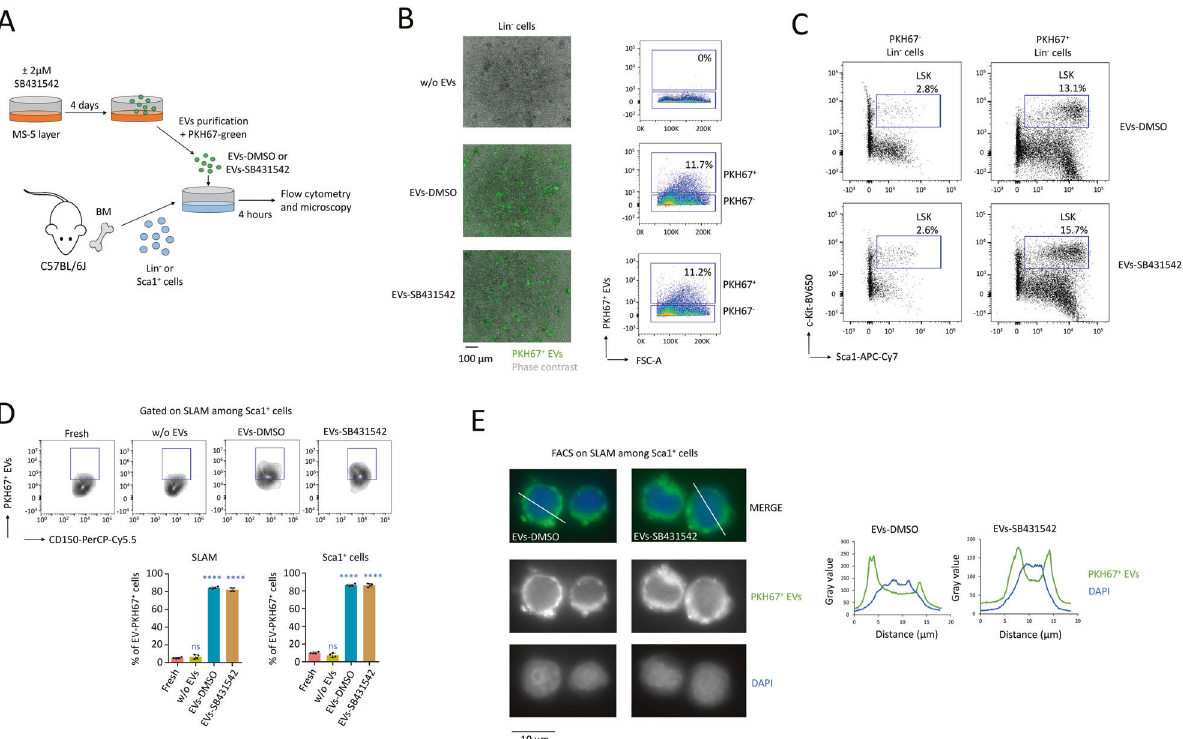
Fig. 4 MS-5 cells produce EVs carrying p-Smad2 that can be uptaken by HSC. A Procedure followed to treat Lin - and Sca1 + cells with PKH67 + EVs-DMSO or EVs-SB431542. We administered 10 9 particles per 10 6 Lin - cells, or 10 9 particles per 4 × 10 5 Sca1 + cells. B Microscopy on a 96-well round bottom plate and fl ow cytometry, after the exposure of Lin - cells during four hours with PKH67 + EVs. Data showing that ~11% of the Lin - cells bound PKH67 + EVs. Magni fi cation ×4, black scale bar corresponds to 100 µm. C Flow cytometry on PKH67 - and PKH67 + gated Lin - cells showing that PKH67 + EVs bound more to HSPC (LSK; Lin - Sca1 + c-Kit + cells). D Sca1 + cells were freshly isolated from the BM of mice (fresh) and treated with EVs-DMSO, EVs-SB431542 or without EVs (w/o EVs) for four hours. Flow cytometry showing the uptake of PKH67 + EVs by >80% of the Sca1 + c-Kit + cells, as well as >80% of HSC (SLAM cells). Data are shown as means ± SD, n = 4 biological samples. P value calculated against the fresh conditions and measured by one-way ANOVA with Tukey ’ s multiple comparison test; **** P < 0.0001; ns, non- signi fi cant. E Fluorescent optical sections, showing the uptake of PKH67 + EVs in the cytoplasm and nucleus of HSC (SLAM cells), puri fi ed by FACS, four hours after incubation with EVs-DMSO or EVs-SB431542. Magni fi cation ×63, black scale bar corresponds to 10 µm, white bars correspond to the sections for measurement of the PKH67 green fl uorescence and